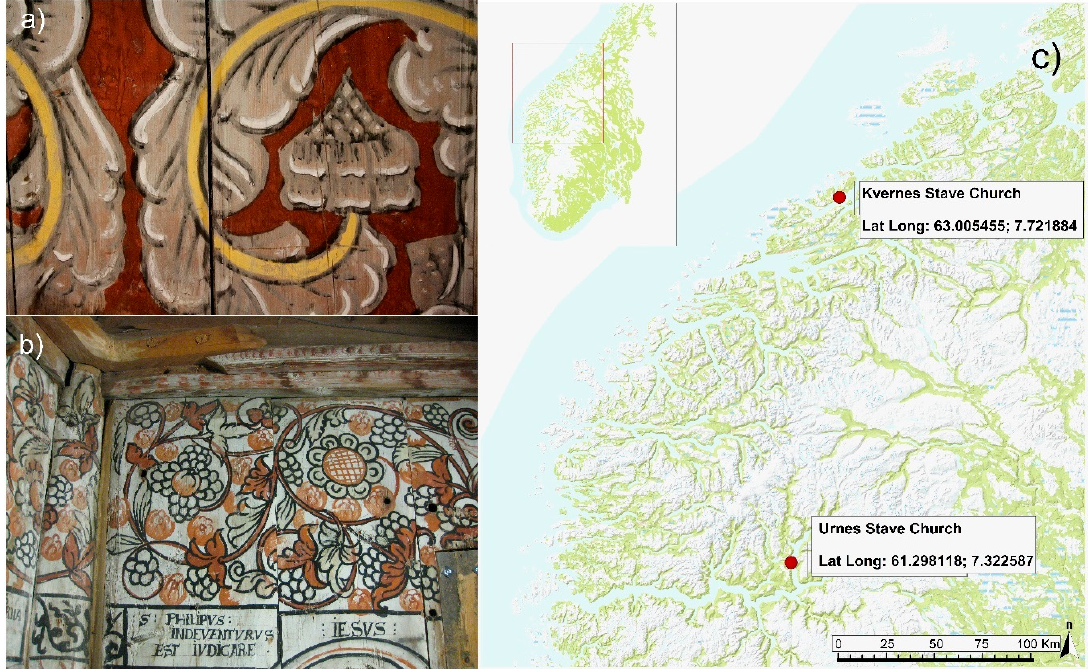
Figure 4. ( a ) Close up of the distemper decorative paint in the nave in Kvernes stave church (date: